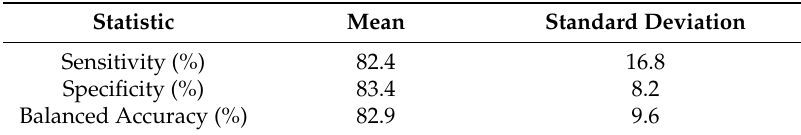
Table 3. Classification results from 51 resamples of the optimal LDA model with additional up-sampling, in terms of sensitivity, specificity and balanced accuracy.